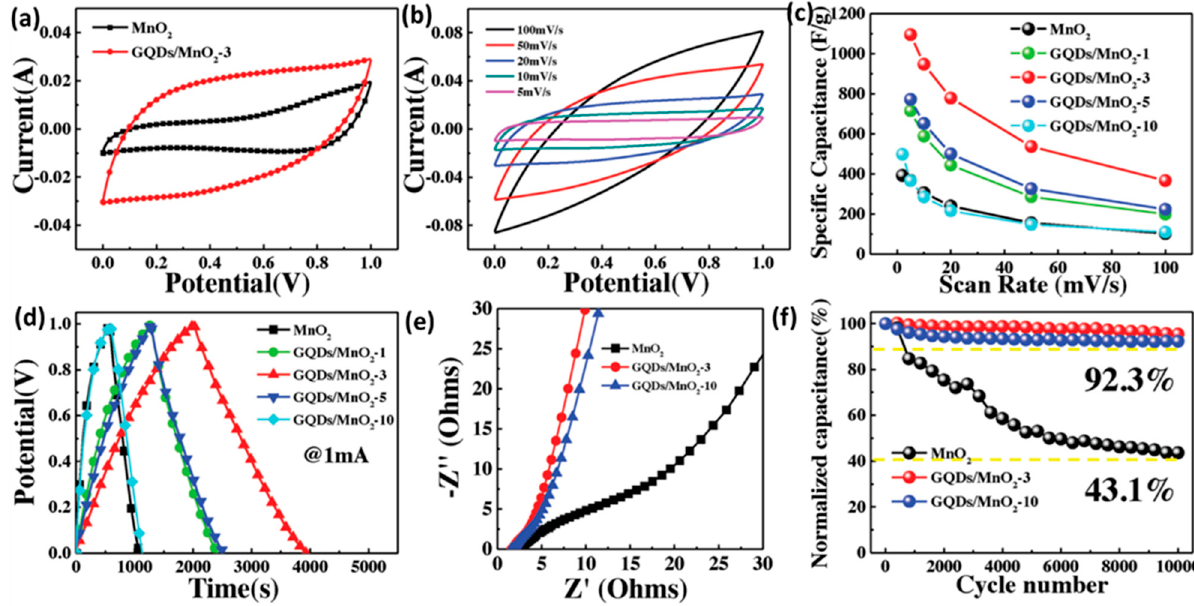
Figure 22. ( a – f ) Improvement in the electrochemical performance of MnO 2 -based supercapacitor electrode with the help of GQDs. Reprinted with permission from Ref. [174].